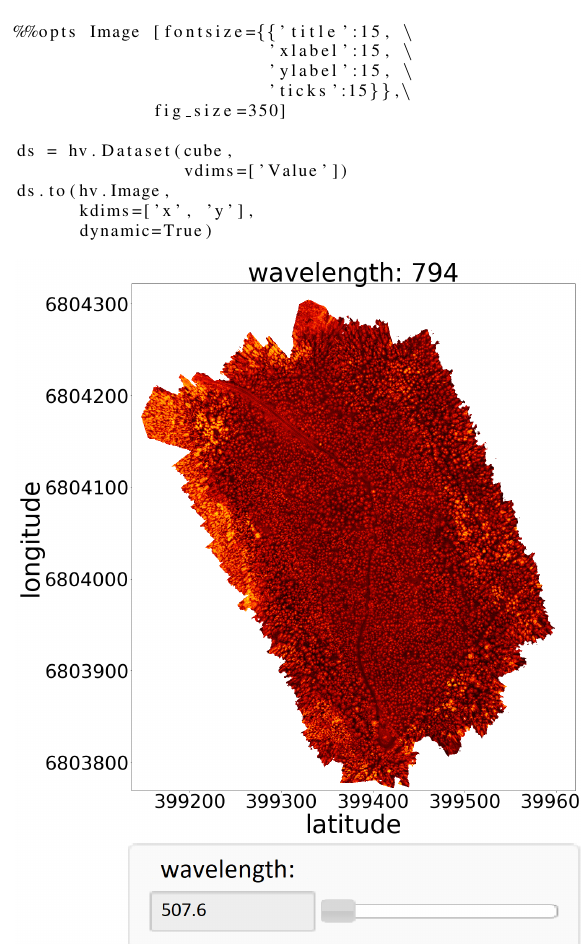
Figure 6. Here we make a more complicated Holoviews visualisation by using Holoviews dataset. From using Dataset, we get a slider that goes through the wavelength bands.